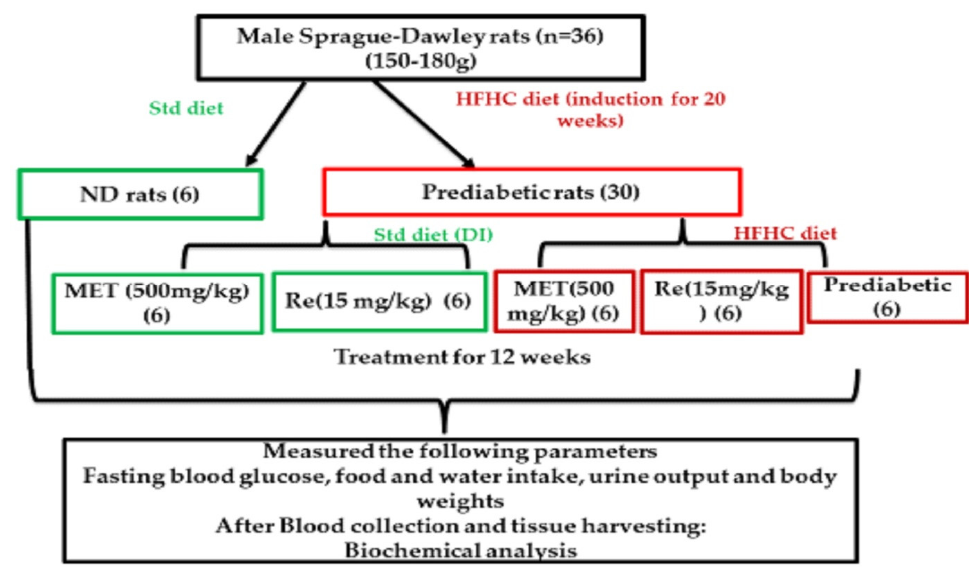
Figure 1. The experimental protocol for the study.